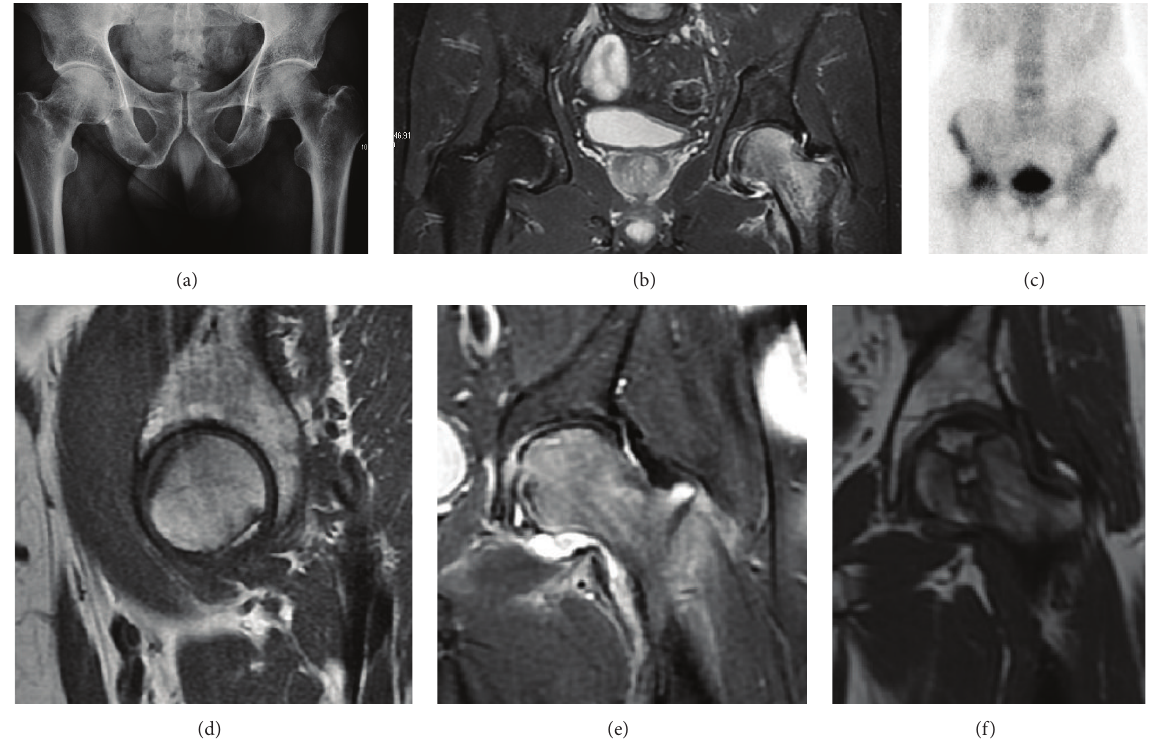
Figure 8: (a) X-ray of a patient with transient osteoporosis of the left hip showing osteoporosis. (b) Coronal stir imaging showing diffuse edema. Scintigraphy (c), sagittal T1 (d), and coronal PD fat sat (e) of a patient with a subchondral fracture of the femoral head with convex shape to the articular surface. Coronal T1 (f) of a patient with avascular necrosis of the femoral